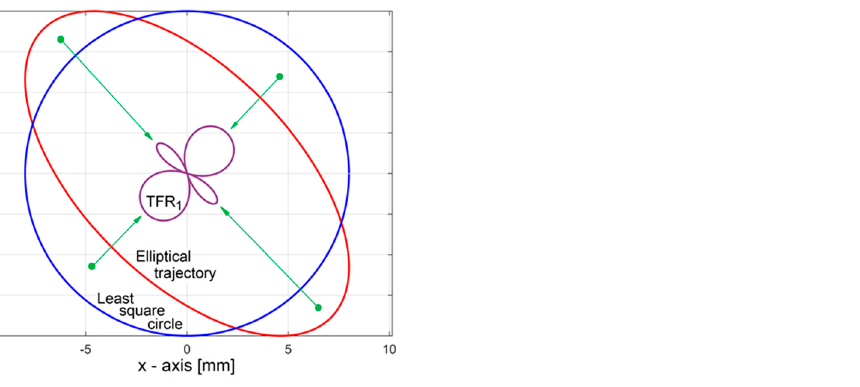
Figure 13. The evolution of TFR 1 generated by circular fitting on an elliptical trajectory (simulation).